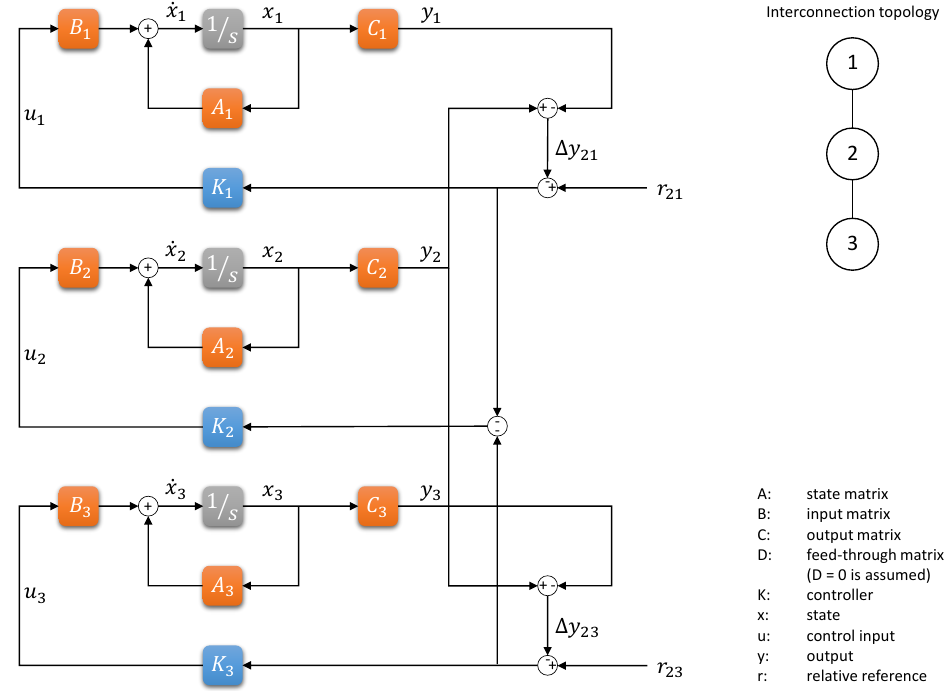
Figure 6. Exemplary block diagram of three distributed systems with their controllers coupled via the consensus approach. The interconnection topology is shown as a graph in the upper right